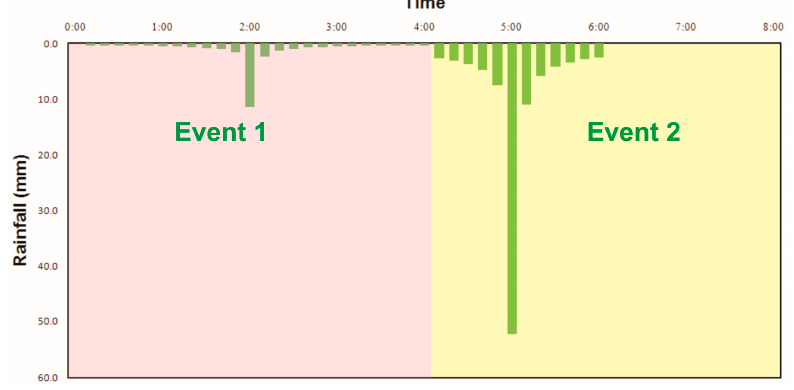
Figure 3. Hypothetical storm with two subsequent events of low and high intensity.